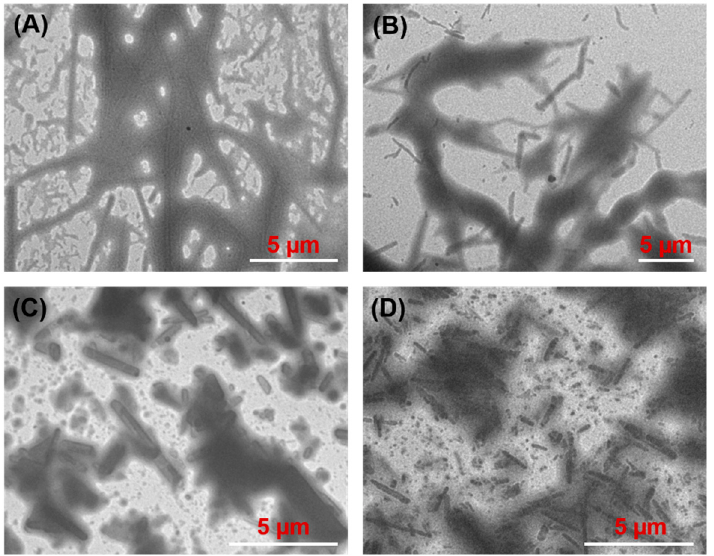
Figure 4. TEM images of oleogels prepared by lysine-based gelators in olive oil: C8-lys-C8 ( A ), C10-lys-C10 ( B ), C12-lys-C12 ( C ), and C14-lys-C14 ( D